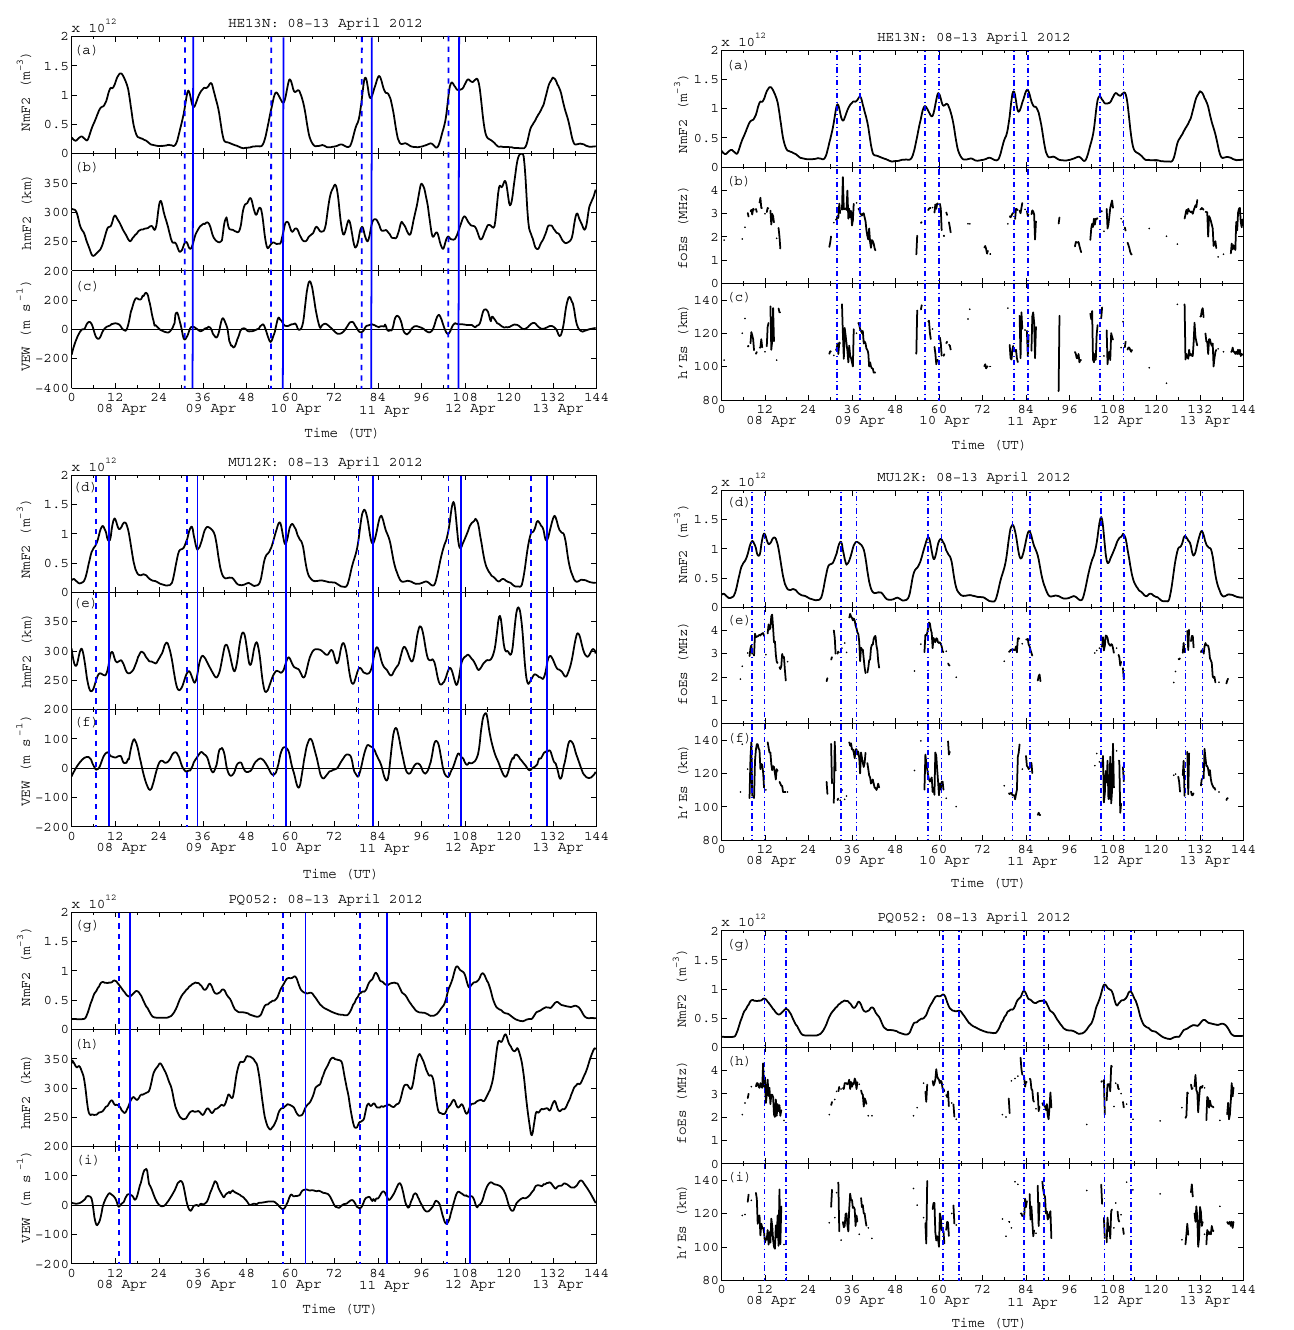
Figure 6. Sporadic E-layer (Es) activity during observations of twin-peak structures as illustrated by its critical frequency, fo Es, in (b) , (e) and (h) and virtual height, h’Es, in (c) , (f) and (i) as measured from Hermanus, Madimbo and Pruhonice ionosondes re- spectively. The vertical blue dash-dot (- · ) lines mark the twin-peak structures observed in Nm F2 from the same stations (in a , d and g